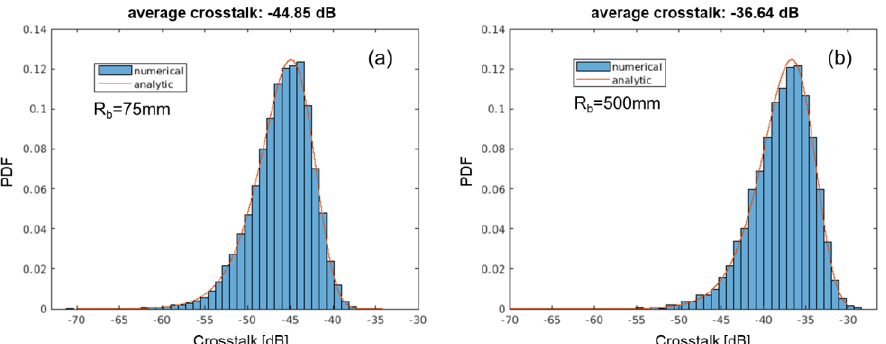
Figure 7. Probability density functions of two-core homogeneous MCF, computed numerically (his- tograms) and analytically [6] (line) for deployments with bend radii ( a ) R b = 75 mm and ( b ) 500 mm.